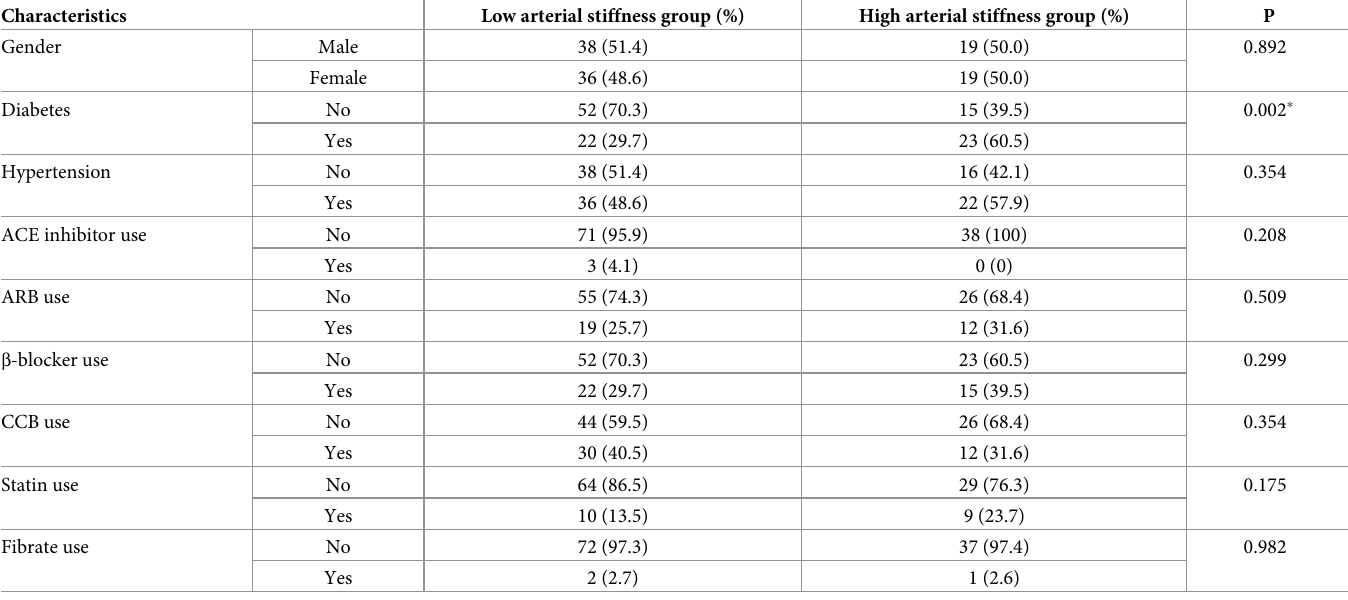
Table 2. Distribution of hemodialysis patients with high or low arterial stiffness in subgroup analysis. Characteristics